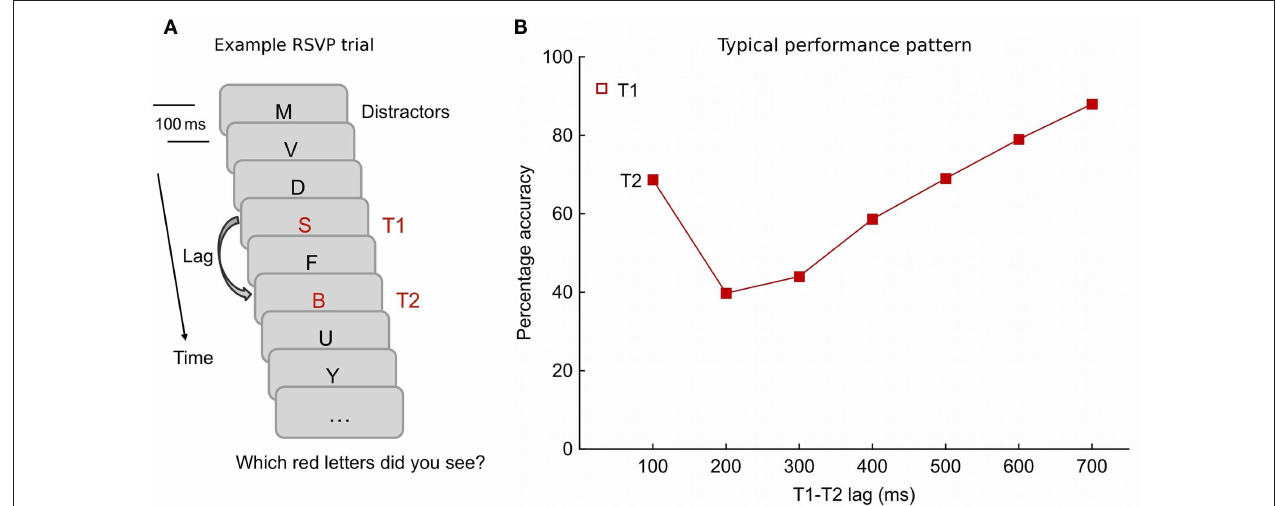
seen at the end of the trial. (B) A hook-shaped performance pattern in the AB task. The profile displays the accurate T2 report given correct T1 identification as a function of lag times. Observers particularly often miss T2 if it falls in a lag window between 200 and 300 ms after T1, but dual target report improves at longer lags. In many instances, superior accuracy translates to the earliest lag (here, 100 ms), where T1 and T2 follow each